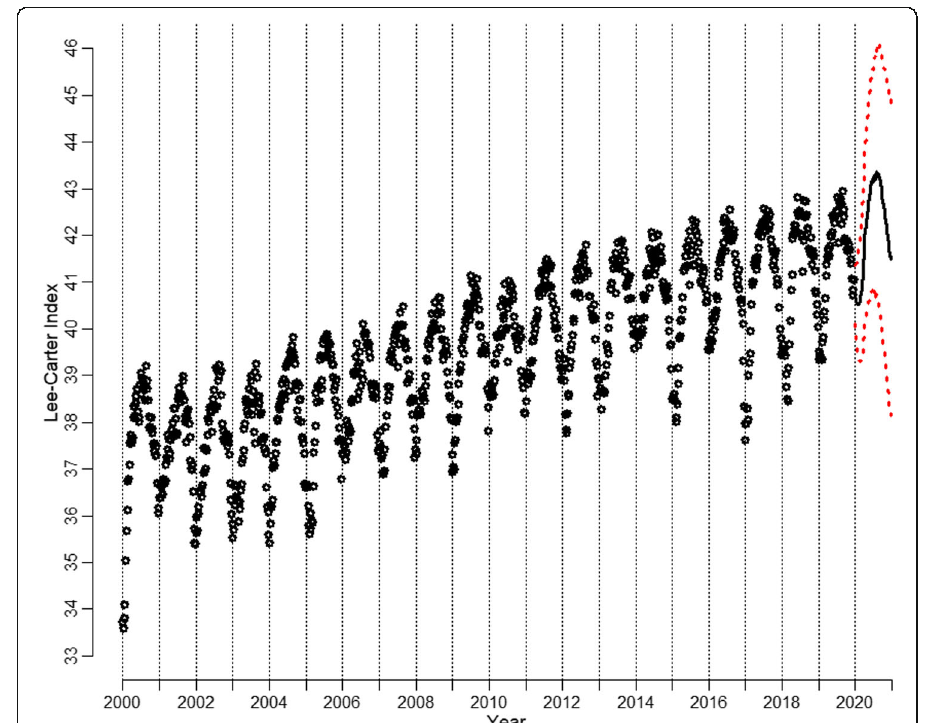
Fig. 4 Historic course of the Lee-Carter Index with median forecast and 95% prediction